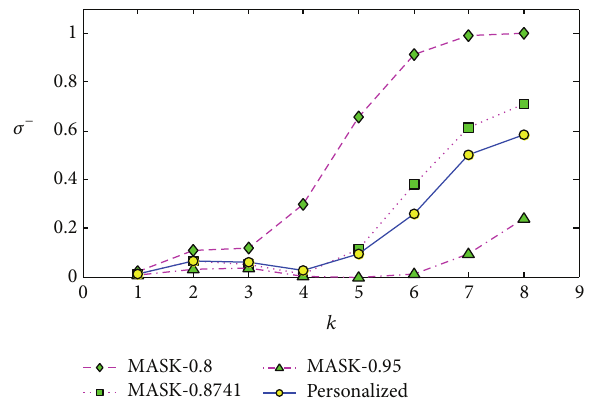
Figure 15: Frequent itemset lost ration 𝜎 − versus itemset length 𝑘 on dataset T40.I10.D100K.N942.